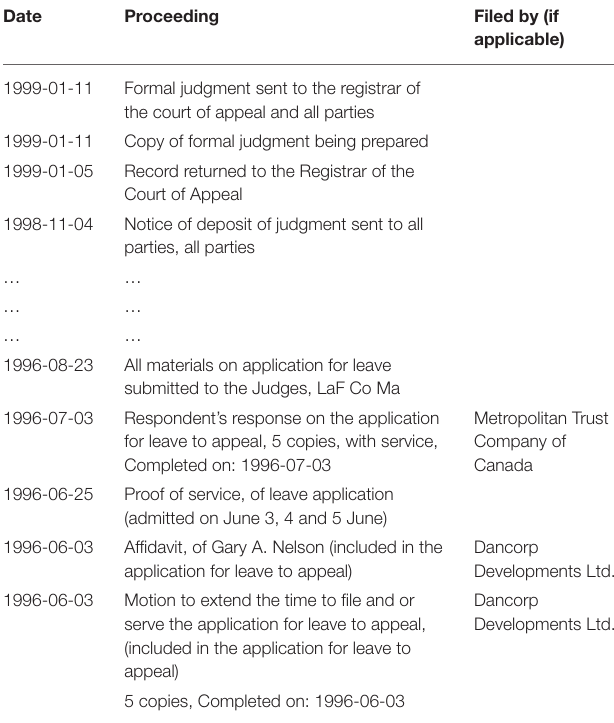
TABLE 1 | Proceedings of Canadian Supreme Court, docket number